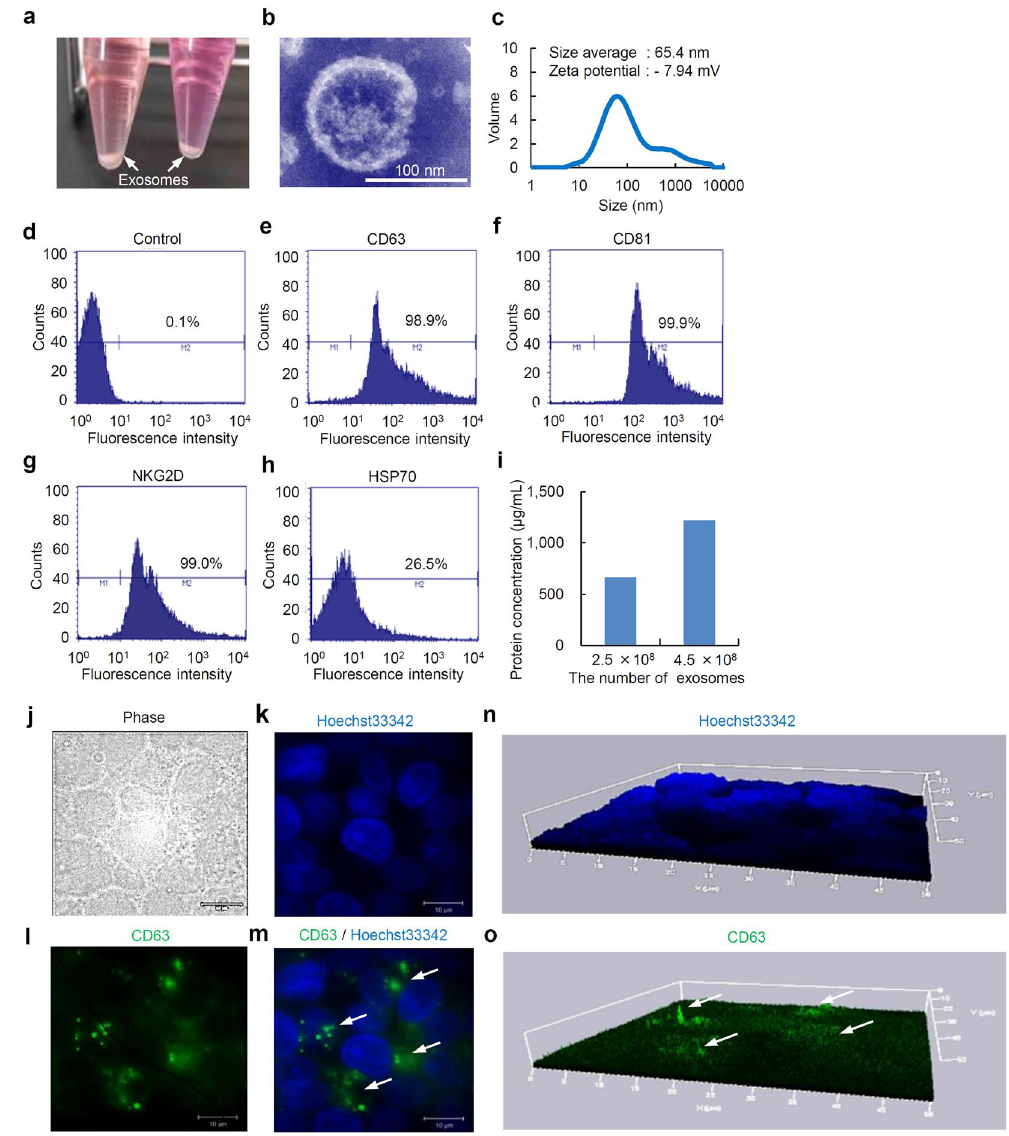
Figure 1. The isolation, characterization, and observation of exosomes secreted from HepG2 cells. ( a ) The exosomes secreted from HepG2 cells (HepG2-exosomes) isolated by the ExoQuick-TC kit in the bottom of the tubes were found as white pellets. Both white arrows show the exosomes. ( b ) An image of transmission electron microscopy of exosomes secreted from HepG2. ( c ) The size distribution, average size and zeta potential of HepG2-exosomes in distilled water. ( d–h ) The expression of marker molecules such as CD63, CD81, NKG2D and HSP70 on the surface of HepG2-exosomes. ( i ) The protein concentration of exosomes secreted from HepG2, as determined by the BCA method. ( j–m ) The exosomes in HepG2 cells were detected by using a FITC-labeled anti-human CD63 mouse monoclonal antibody. The morphology of the cells ( j ), nuclei labeled with Hoechst33342 ( k ), exosomes labeled with FITC-labeled anti-human CD63 mouse monoclonal antibody exist in HepG2 cells ( l ) and the merged images of the nuclei and exosomes ( m ) are shown. White arrows show the exosomes. ( n,o ) Three-dimensional images of nuclei labeled with Hoechst33342 ( n ) and exosomes bound to the FITC-labeled anti-human CD63 mouse monoclonal antibody ( o ) found in HepG2 cells. White arrows show the exosomes. These figures were obtained using superresolution structured illumination microscopy (SR-SIM, Carl